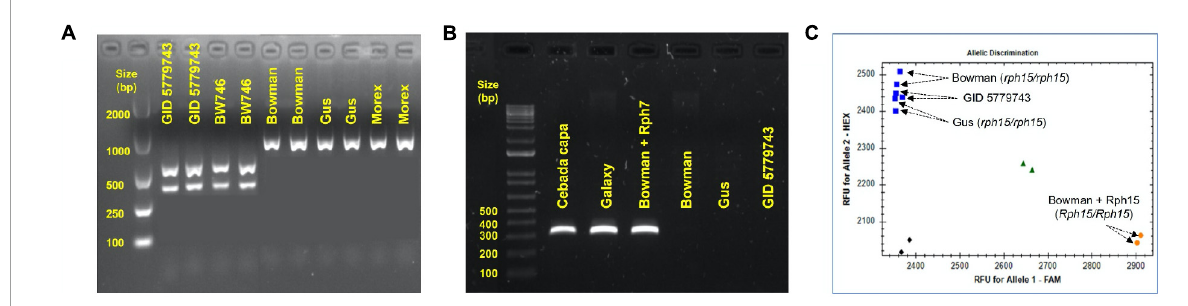
FIGURE1 Genotype of GID 5779743 using various closely linked markers with known Rph genes. (A) The barley line BW746 is the NIL of Bowman carry Rph3 that was used as the positive control. The Rph3 gene is absent in the other barley cultivars, namely Bowman, Gus, and Morex, which were used as negative controls. (B) The absence of the resistance gene Rph7 in the barley line GID 5779743 confirmed by marker genotyping. The dominant marker gives the amplicon of 319 bp in length when the gene is present in the barley cv. Cebada Capa, Galaxy, and Bowman+Rph7 while it is absent in three barley cv. Bowman, Gus, and GID 5779743. (C) The absence of the resistance gene Rph15 in the barley line GID 5779743 was confirmed by marker genotyping. KASP marker illustrated the presence of Rph15 in the barley NIL line Bowman+Rph15 by the orange dot in the bottom-right corner, the blue squares in the top-left corner demonstrated the absence of Rph15 in three barley cv. Bowman, Gus, and GID 5779743, the green triangles showed the heterozygous form ( Rph15/rph15 ) while the black diamonds in the bottom-left corner represented the water as no template control. All the PCRs were performed three time and generated similar results.